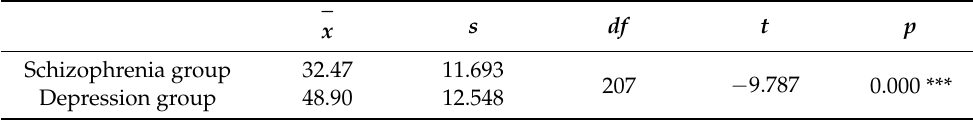
Table 2. The difference in age between the two groups.